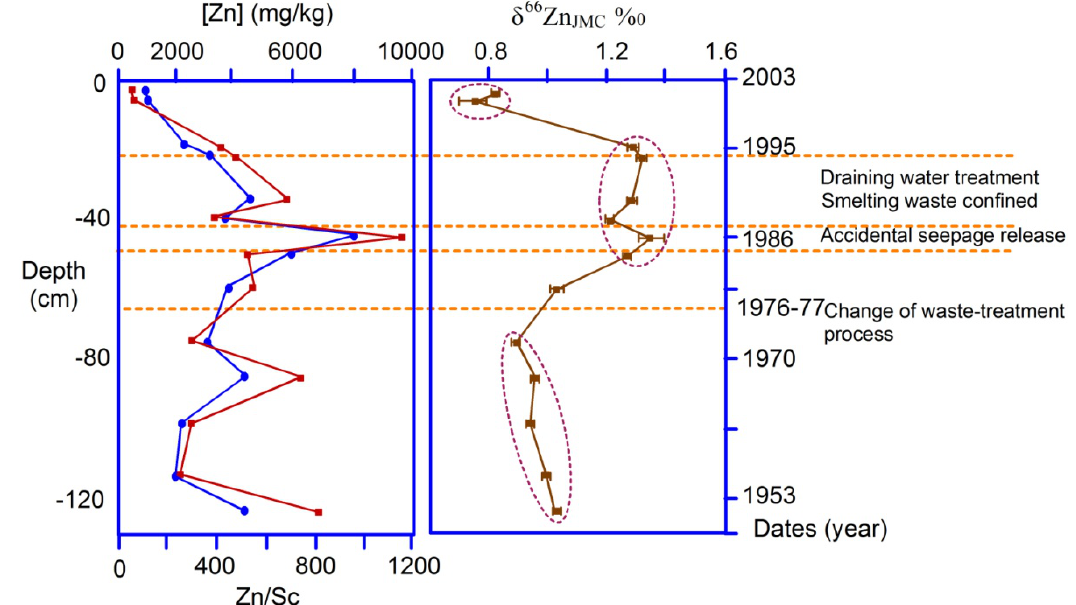
Figure 13. Vertical (depth/time) variations in total Zn concentrations (red squares), Zn/SC ratios (blue circles), and δ 66 Zn values (brown diamonds) measured in samples from a core extracted from the Cajarc reservoir along the Lot River, France (figure from Sivry et al. [196]; Zn and Zn/Sc variations from Audrey et al. [101]). The correlation between Zn concentration and isotopic trends suggest that Zn isotopes can be used to determine Zn